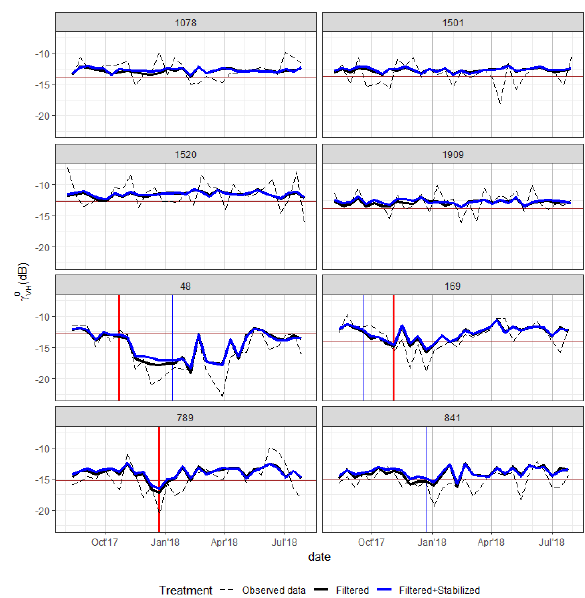
Figure 9. Results of the deforestation detection procedure on 8 random locations. Upper 2 row time-series correspond to intact forest areas. Lower 2 row time-series come from deforested areas. Horizontal brown line represents the detection threshold for the stabilized series. The vertical red line is a confirmed alert. Blue lines show when the DETER optical detection system flagged the location as deforested.